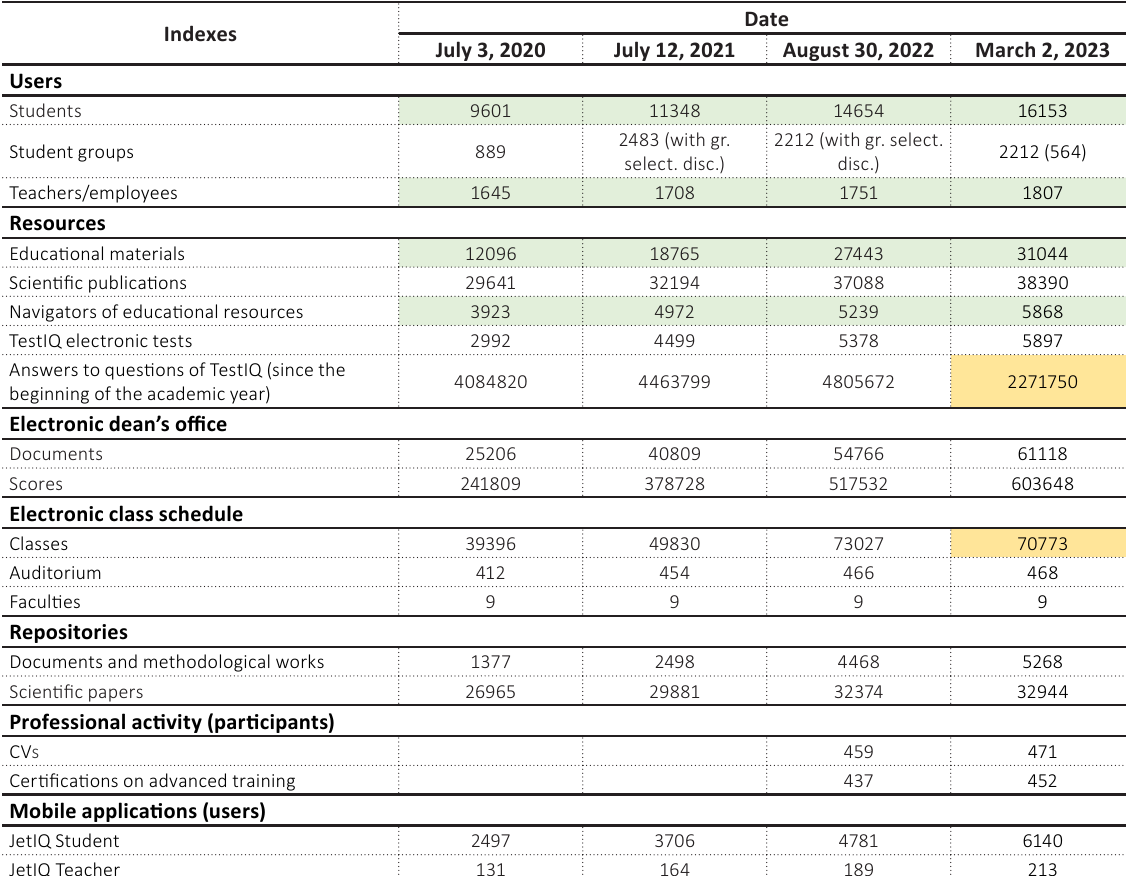
Table A1. Protocol indicators of the JetIQ electronic system, which characterize the educational activity of